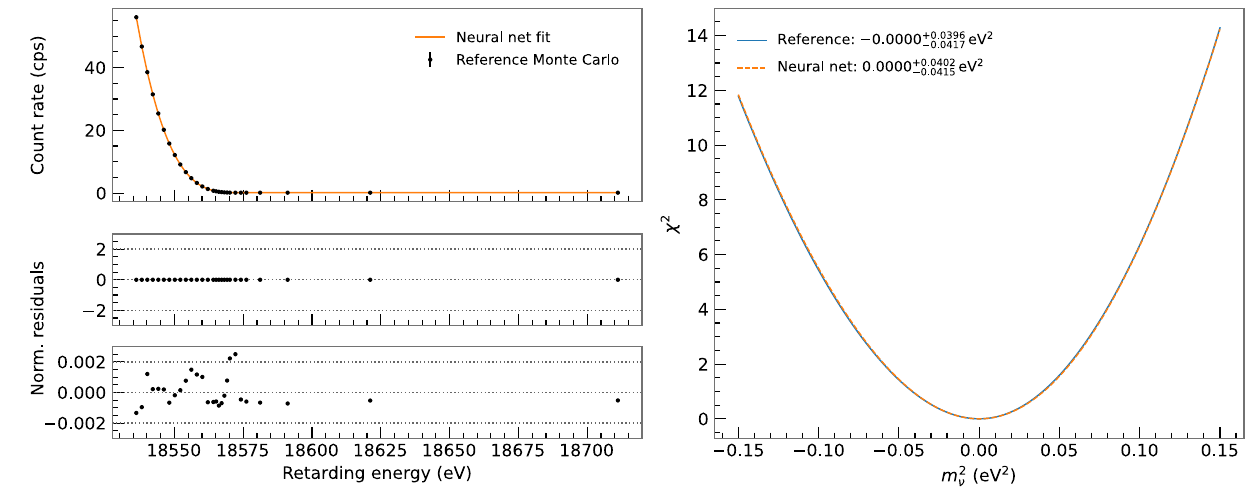
Fig. 4 Left: spectrum and residuals for the Asimov cross-fit. On the top we see the generated Monte Carlo spectrum (black points) as well as the best-fit using the neural network (orange line). On the bottom we plot the normalized residuals, once with a regular scale, and once